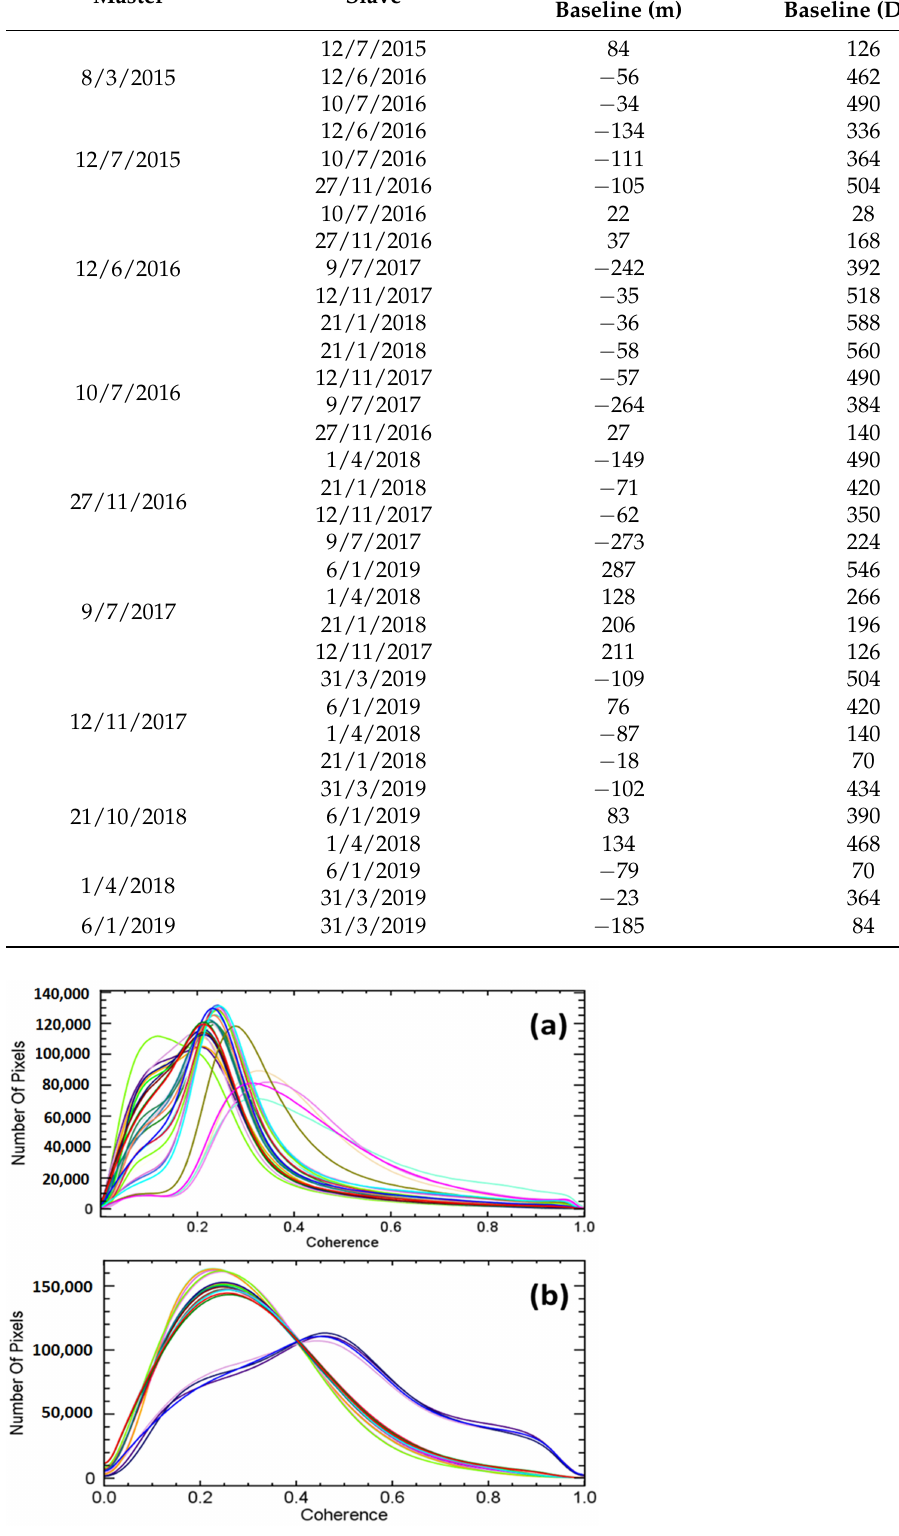
Figure 5. Illustrates the coherence values distribution of interferograms produced from the ALOS-2 data ( a ) and coherent interferogram values produced from the Sentinel-1 data ( b ). The generated interferograms, which show strong residual phase ramps and jumps originated from the orbital inaccuracies, together with large atmospheric artifacts, were corrected by removing the residual phase frequency. Since Alexandria City lies in a coastal area with a dense cloud cover during the winter season, the atmospheric artifact was expected to cause a negative effect on the interferograms quality. The very large temporal or normal baseline between the two acquisitions resulted in the generation of wrapped interferograms with very low coherence; thus, these interferograms were dis- carded (Figure 6).